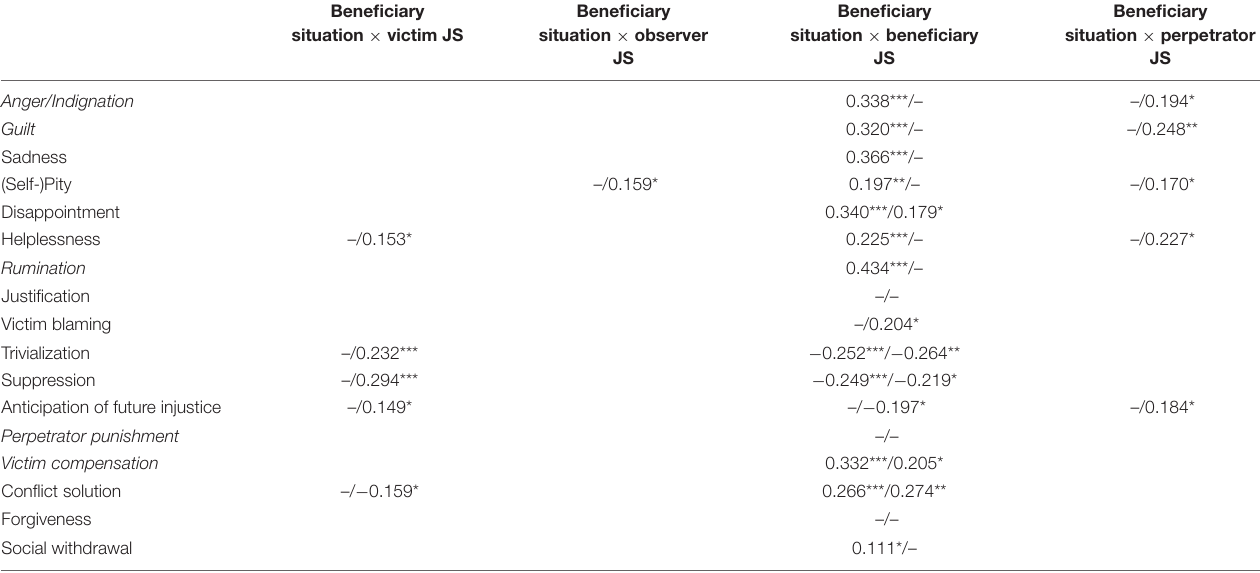
TABLE 7 | Prediction of responses in situations from the beneficiary’s perspective by the JS facets when including only beneficiary JS/all variables.